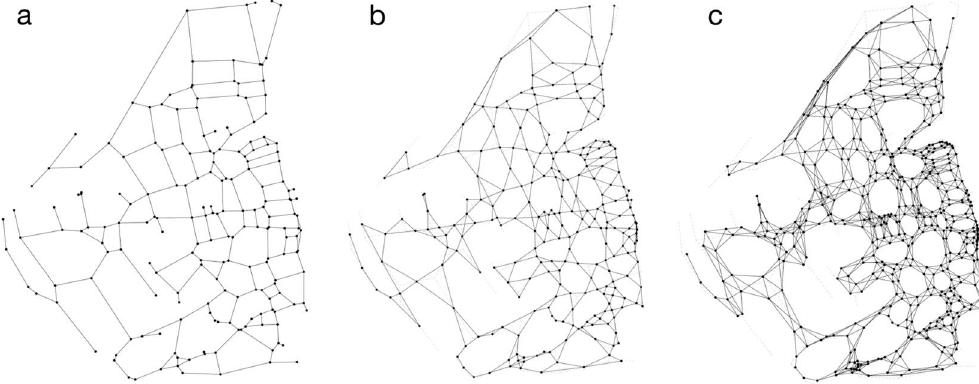
Figure 4. ( a ) Example of a primal graph of a street network ( G ), ( b ) line-graph generated from that primal graph ( G ′ = L ( G )), ( c ) line-graph of the line-graph ( G ″ = L ( L ( G ))) which is the lattice of our